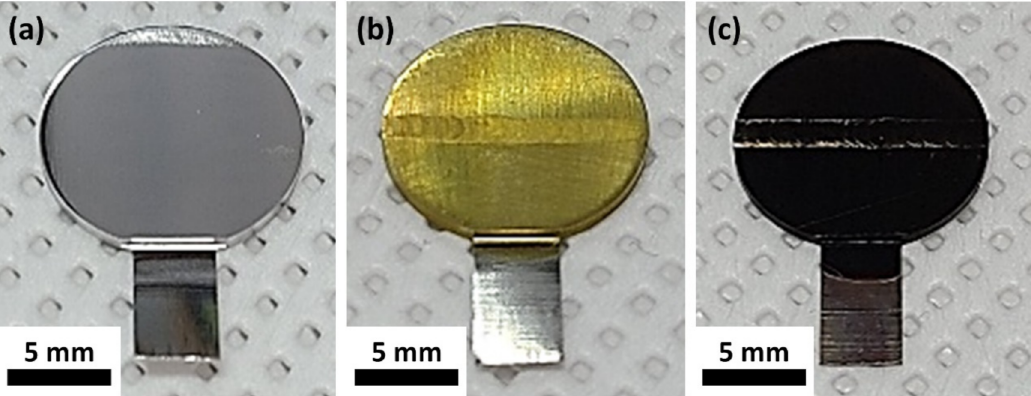
Figure 1. Digital images of welded SS ( a ), anodized welded SS ( b ), and heat-treated anodized welded SS ( c